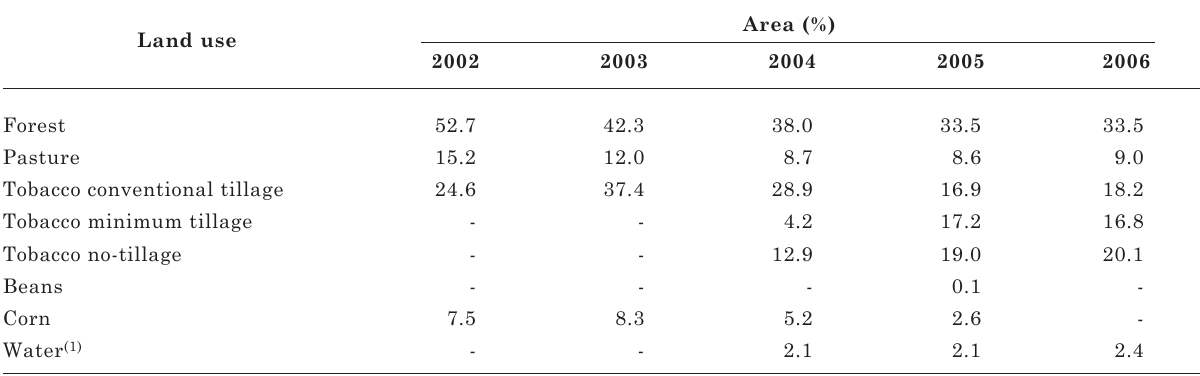
table 1. land use and soil management in the arvorezinha watershed during the simulated period